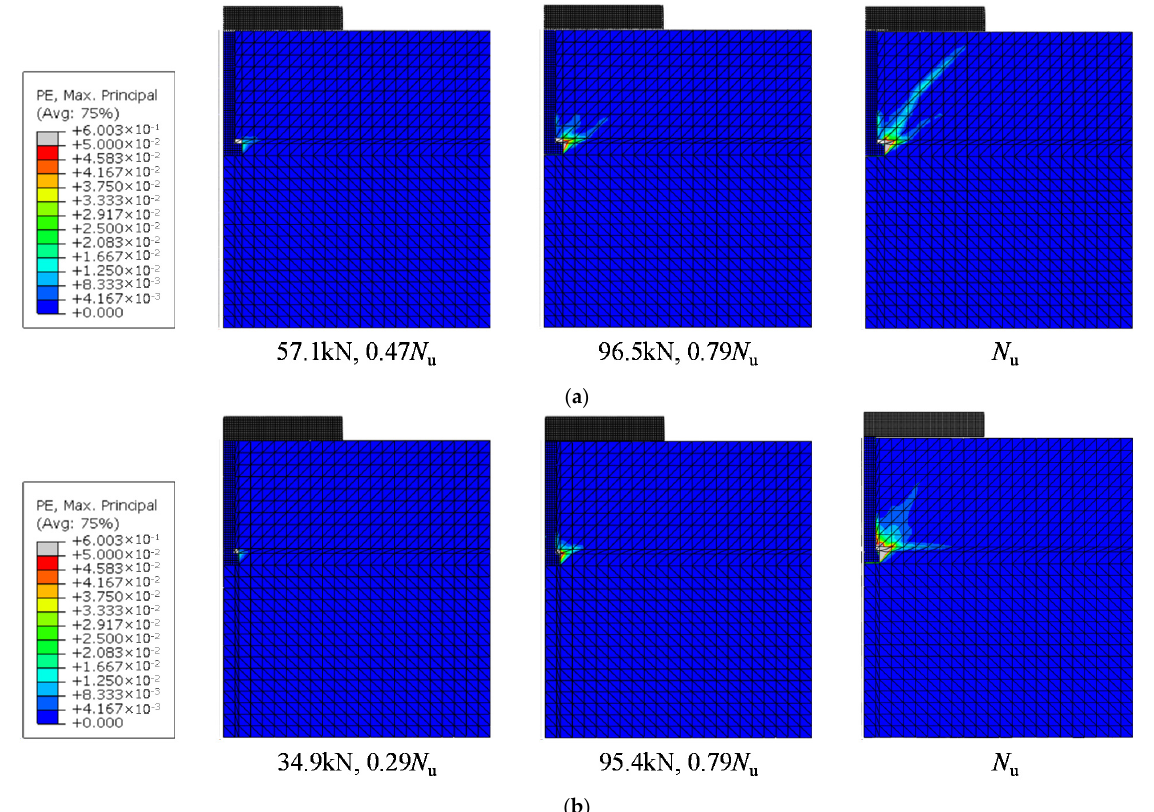
Figure 13. Maximum principal plastic strain at different loading stages: ( a ) NC19-2; ( b ) NC19-38.